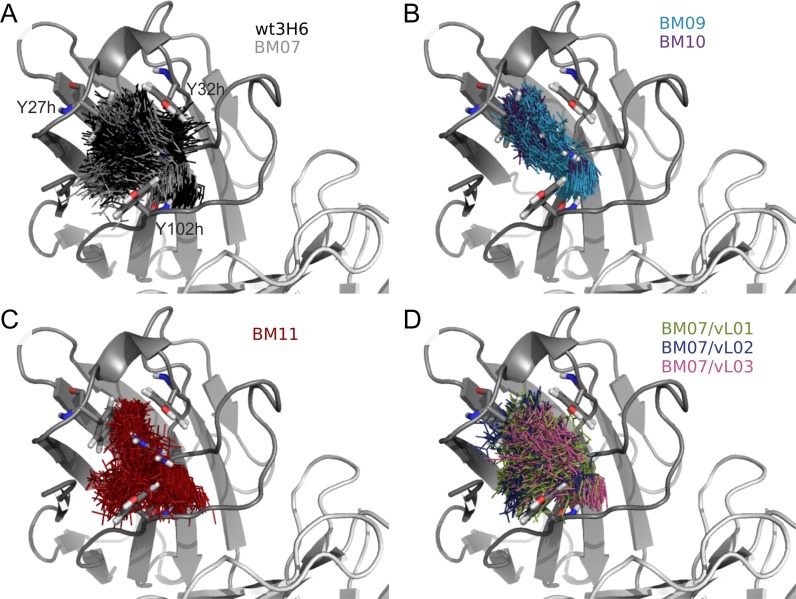
Snapshots (1 per ns) of arginine or lysine at position 94h visualizing the flexibility of residue 94h in the variants. (A) black, gray = wt3H6, BM07; (B) blue, purple = BM09, BM10; (C) red = BM11 and (D) green, blue, pink = BM07/vL01, BM07/vL02, BM07/vL03. The cartoon and sticks are from the wt3H6 crystal structure.